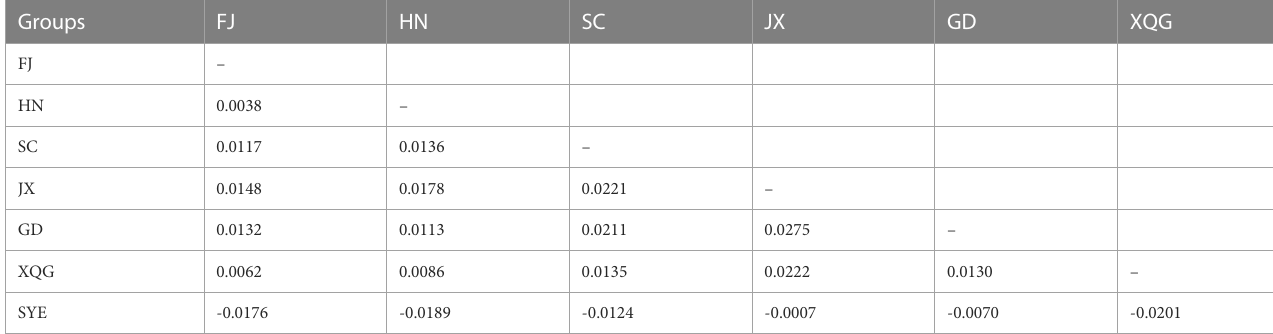
TABLE 2 Genetic differentiation among the different provenances of Chinese fi r.